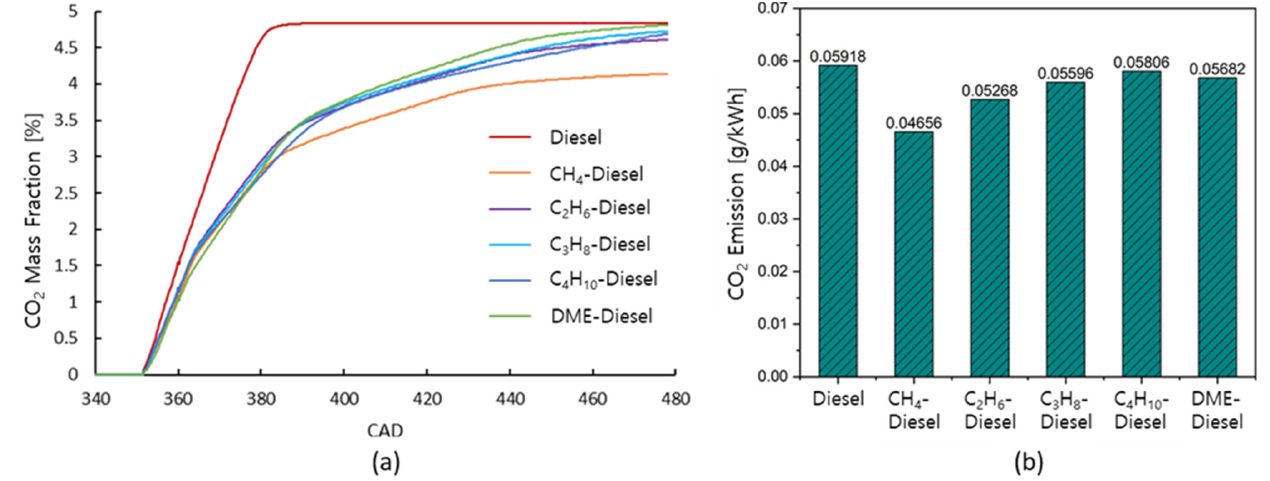
Figure 16. Mean CO 2 mass fractions ( a ) and CO 2 emission masses ( b ) in all combustion cases